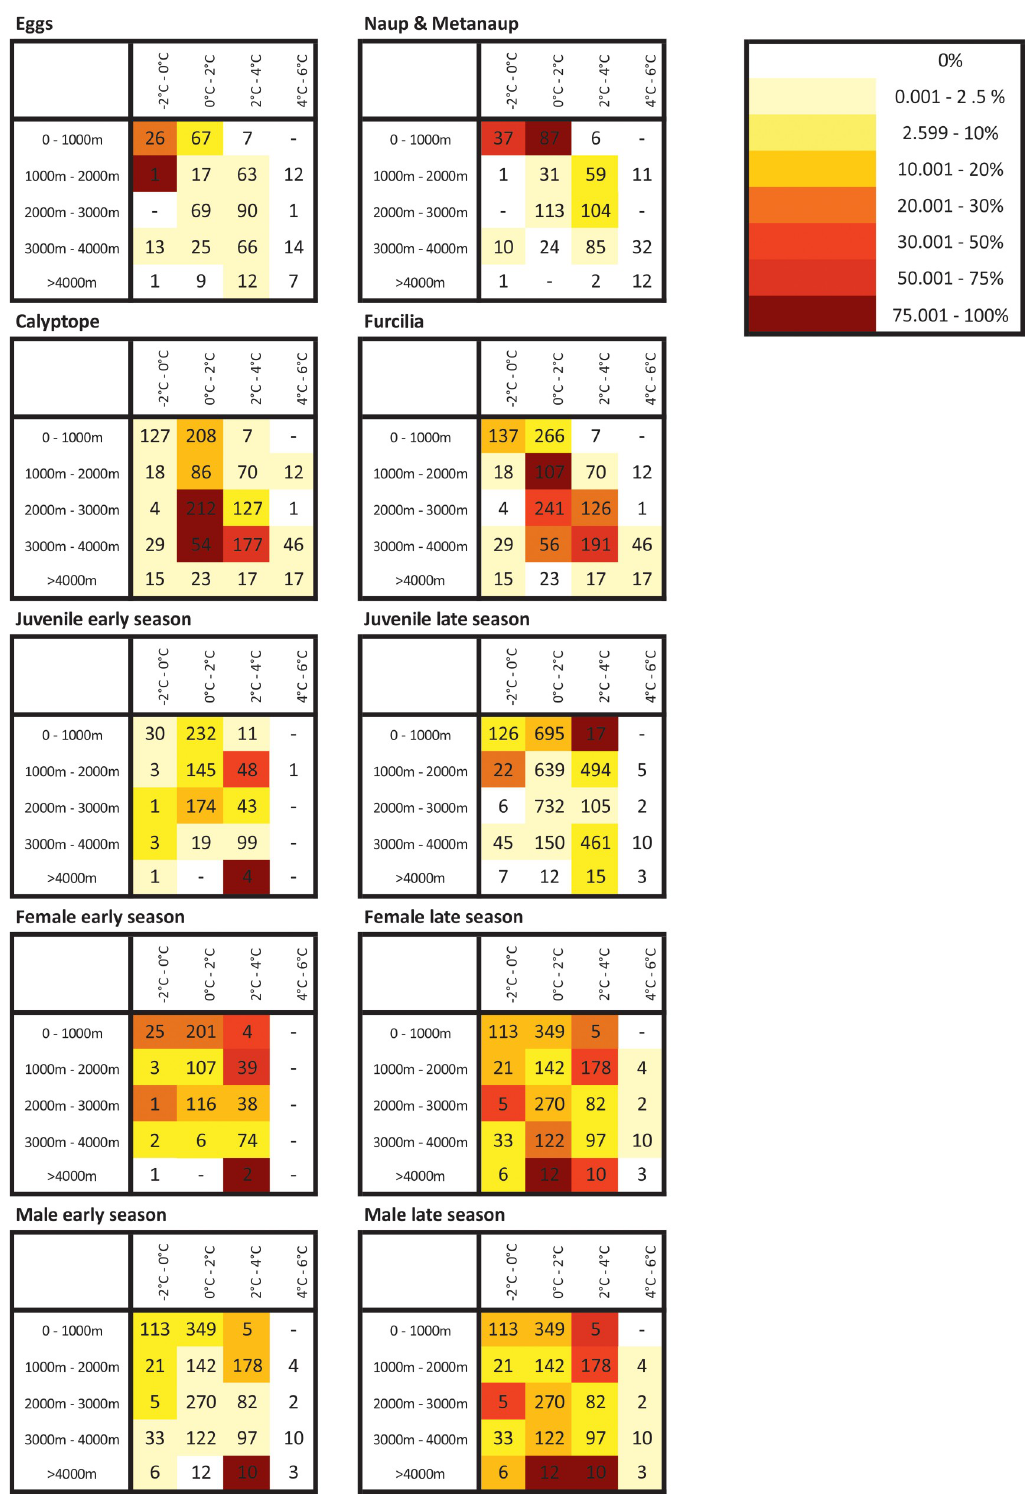
Fig 6. Relative densities of krill life stages in relation to water depth and temperature. To help comparison across the multiple life stages, the colour coded values within each combination of water depth and temperature are normalised by calculating them as percentages of the maximum value (i.e. the water depth-temperature combination with the highest mean krill density). “Early” denotes the period October-December inclusive. “Late” is January to May. Number of stations contributing to each density estimate is provided for each